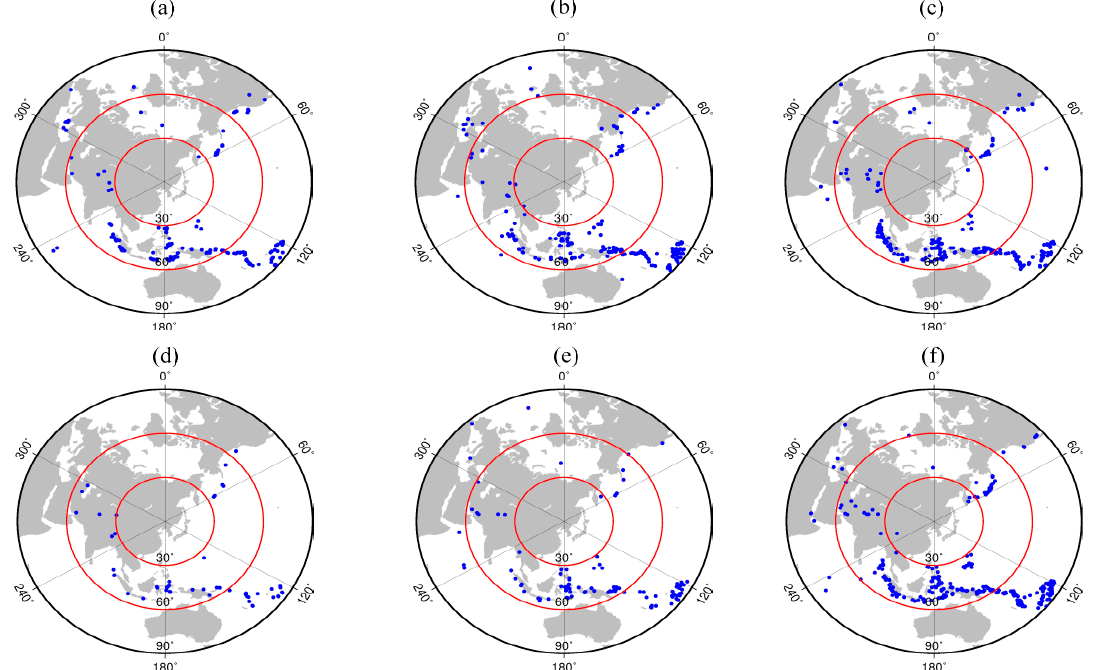
Figure 4. Distribution of teleseismic events selected by different arrays: ( a ) 1A; ( b ) 1U; ( c ) XG; ( d ) XI; ( e ) ZX; ( f ) NE.